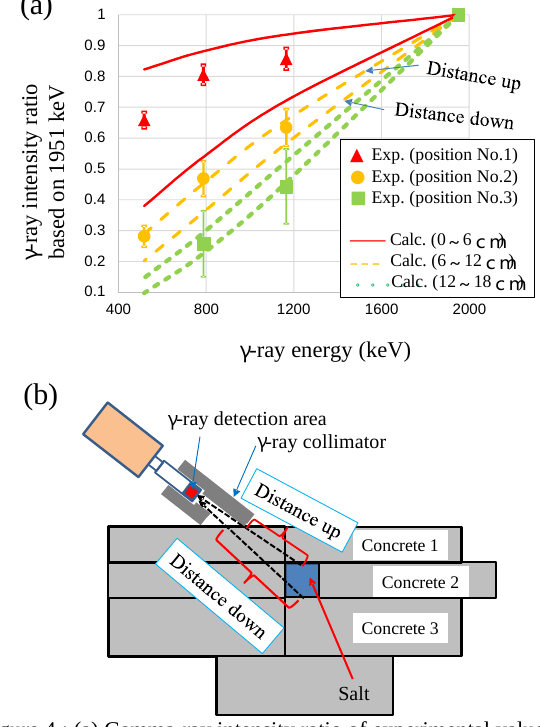
Figure 4 : (a) Gamma-ray intensity ratio of experimental values and calculation based on the 1951 keV γ -ray. (b) Distance passing through concrete in case of position No.2. Table 2. Weight ratios of elements contained in a standard concrete and the capture cross sections of thermal neutron of 25 meV. Element H C O Mg Al Si K Ca Fe Cl Cross section for thermal